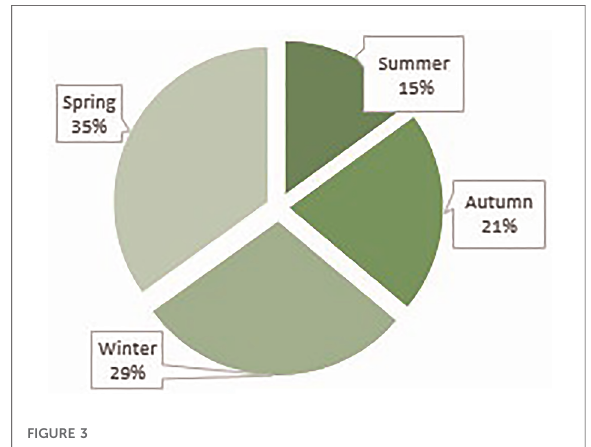
FIGURE 3 Seasonal variation amongst hypothermic